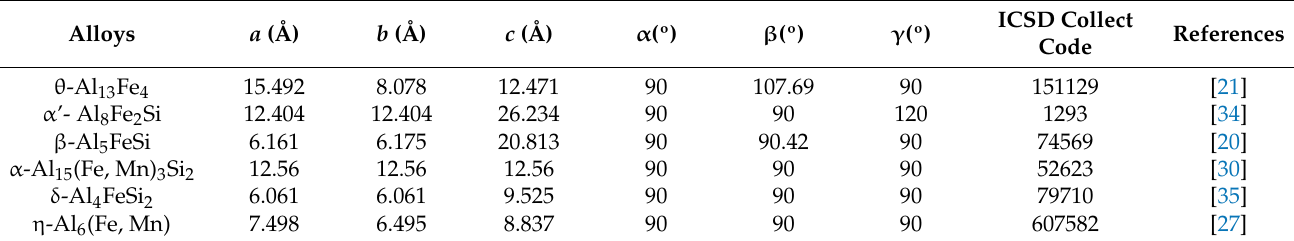
Table 1. Crystal lattice parameter of FIMC phases from